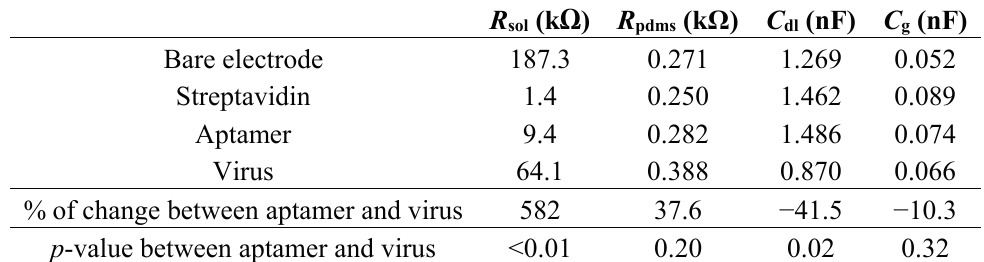
Table 1. Contributions of the elements in the equivalent circuit to the impedance